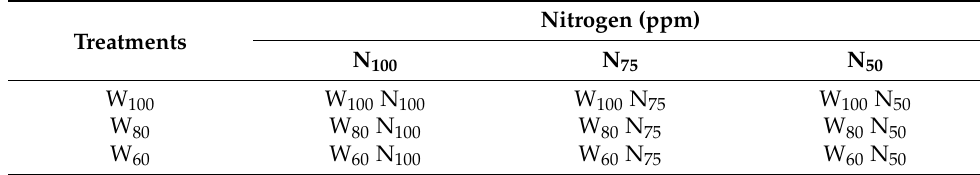
Table 1. The treatment detail of the experiment.